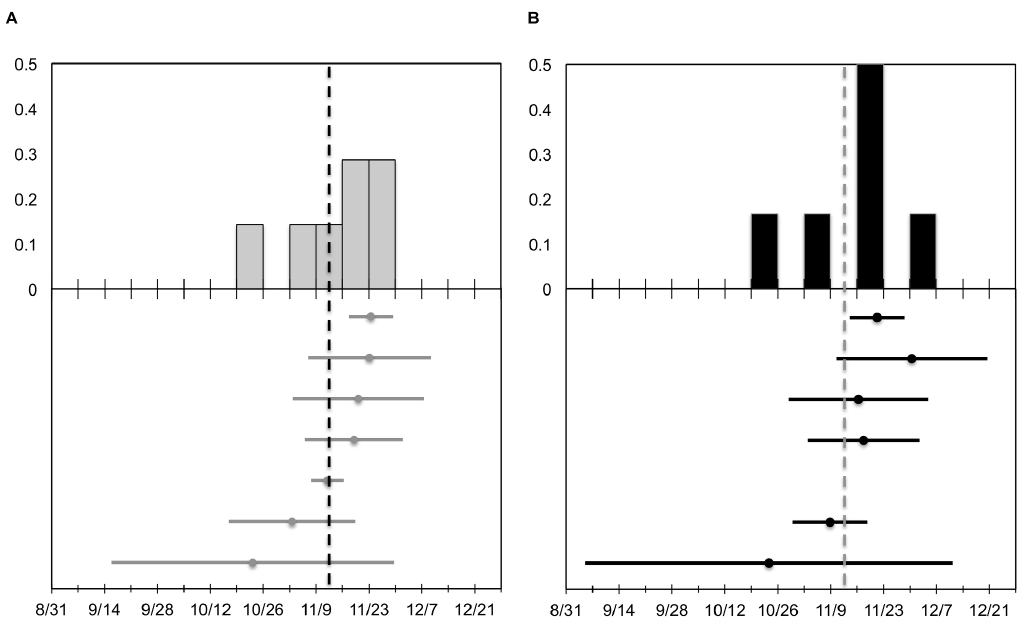
Figure 4. The midpoint and duration of migration in autumn 2011 for seven adult mallard hens. Upper panes illustrate the frequency distribution for the midpoint of autumn migration according to (a) geopolitical method and (b) ND approach. Lower panes illustrate corresponding migration midpoints (circles) and extents (bars) for each of the methods. Vertical dashed lines represent the mean migration midpoint. See text for a description of sample size discrepancy between (a) and (b).